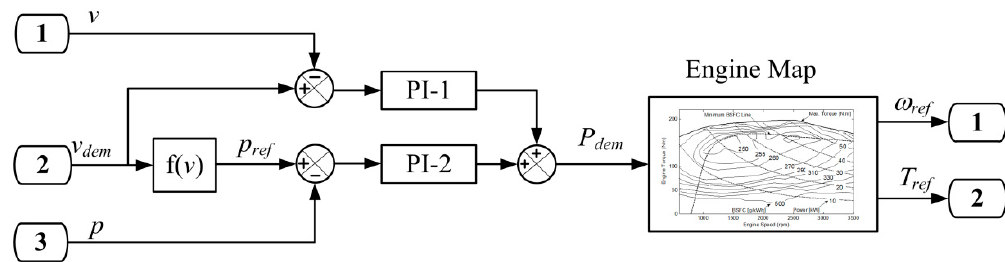
Figure 6. Schematic of Modulated ‐ Pressure Control Strategy.